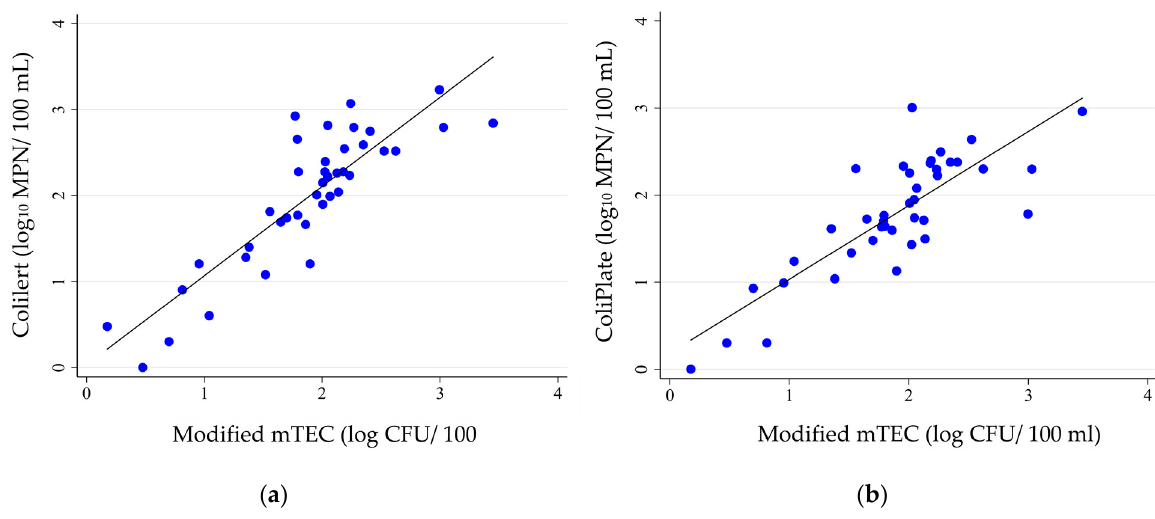
Figure 2. Scatterplots with a linear regression line depicting the relationship between the results obtained by the membrane filtration (mTEC agar) method with the results obtained by ( a ) the ColiPlate method and ( b ) the Colilert method.